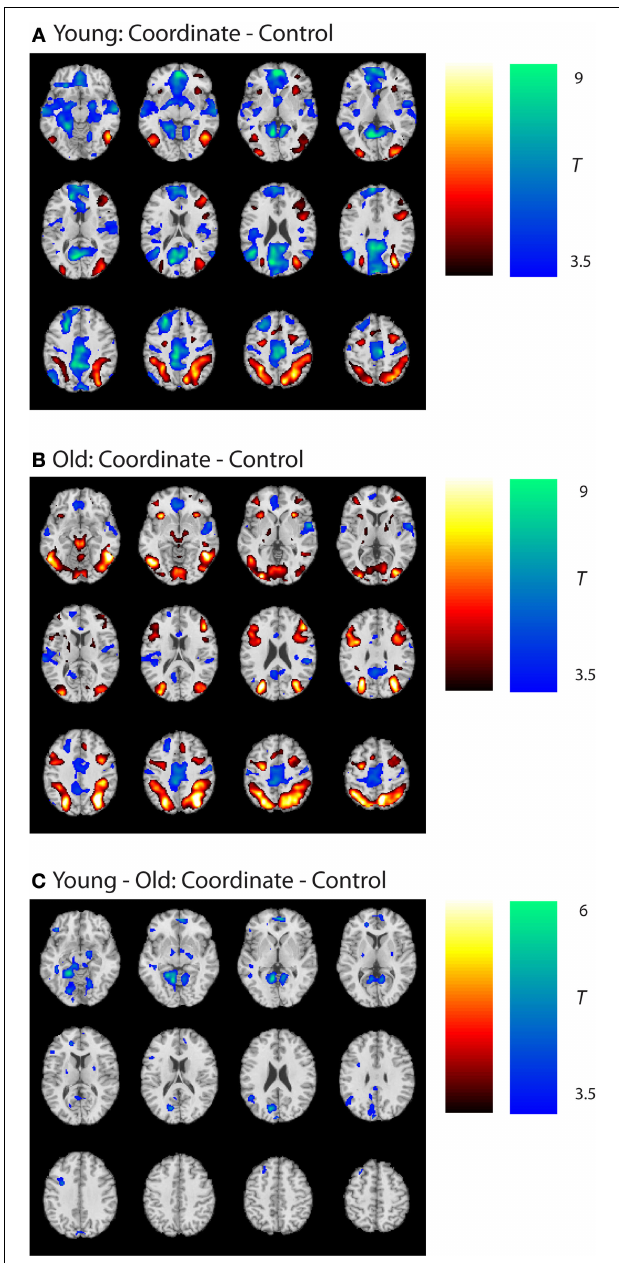
FIGURE 3 | Group statistical maps, age effects. (A) Coordinate–control task T- map for young subjects. (B) Coordinate–control task T- map for old subjects. (C) Coordinate–categorical tasks T- map for young–old (Age × Task interaction). Note the reverse contrast reveals no signifi cant activation. All maps thresholded at p < 0.001 with no cluster correction, and reverse contrasts shown in cold colors.